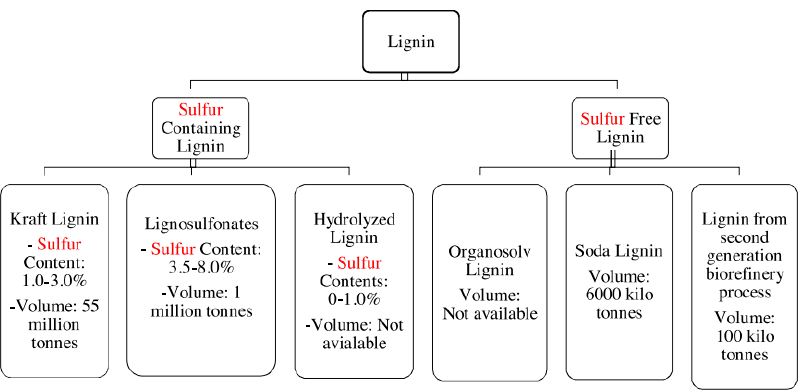
Figure 6. Different sources of lignin and their current volume on scale global [41].